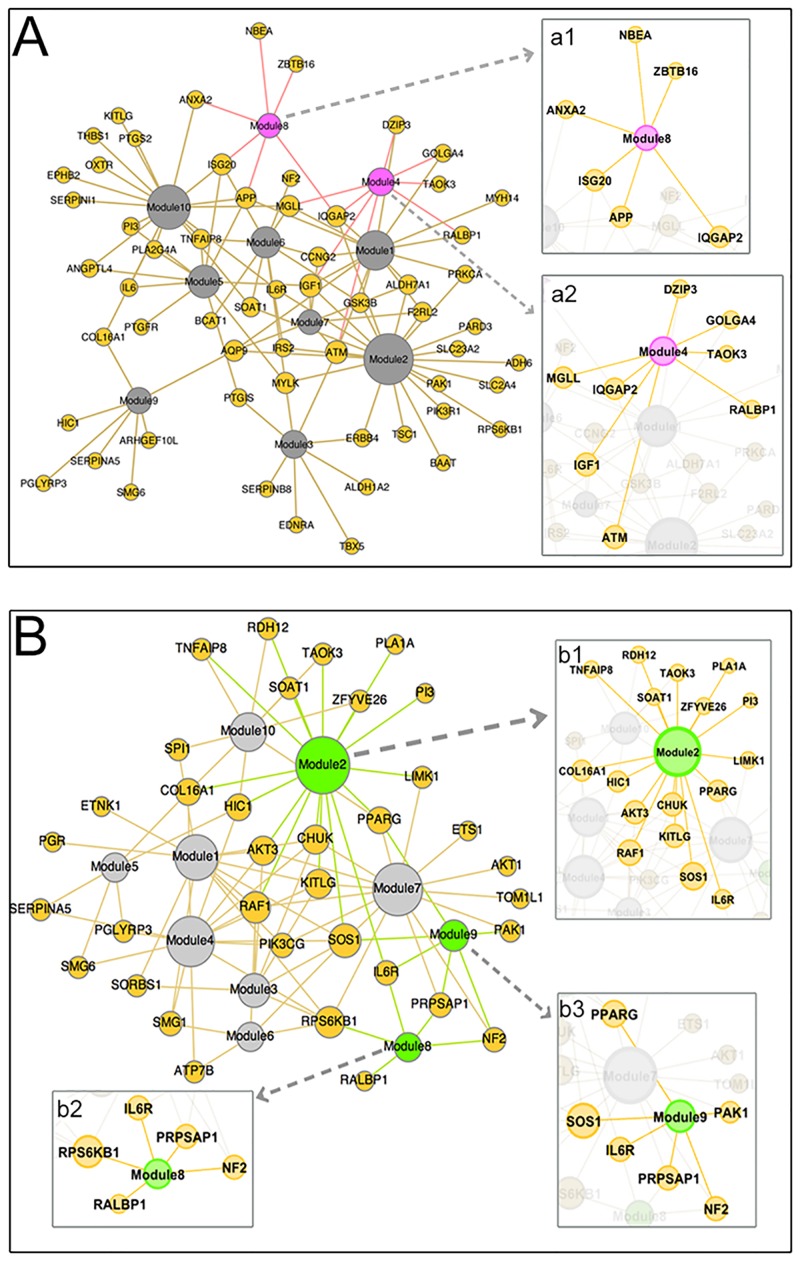
Network of modules and their gene sets.(A) Network output showing all 10 modules from the exome library and the genes contained in each module. The two significant modules are displayed as insets. Inset a1 and a2 display the genes of E8 and E4 respectively. (B) Network output showing all 10 modules from the haplotype block library and the genes contained in each module. Insets b1, b2 and b3 show the genes of H2, H9 and H3 respectively.